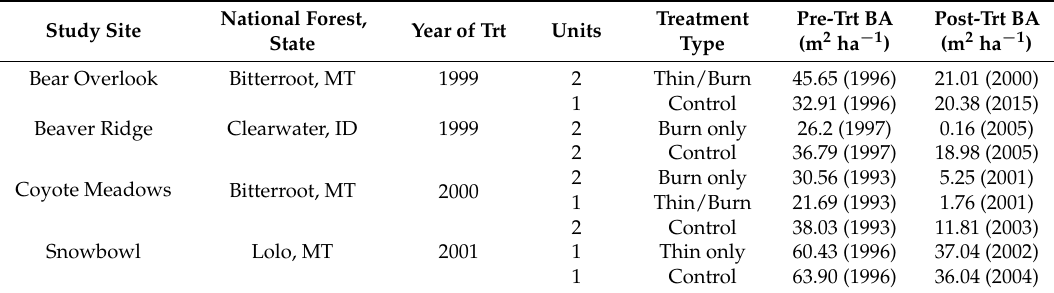
Table 1. Location of study sites, year of treatment (Trt), number of units sampled, treatment type, and pre- and post- treatment (Trt) basal areas (BA; m 2 ha − 1 ) in the long-term monitoring plots in both control and treatment units (Keane and Parsons 2010) [3]. Pre-BA = average pre-treatment basal area, collected from the monitoring plots before the treatment occurred, the year of data collection is in parentheses. Post-BA = average post-treatment basal area, collected from the monitoring plots 1–15 years after treatment occurred, the year of data collection is in